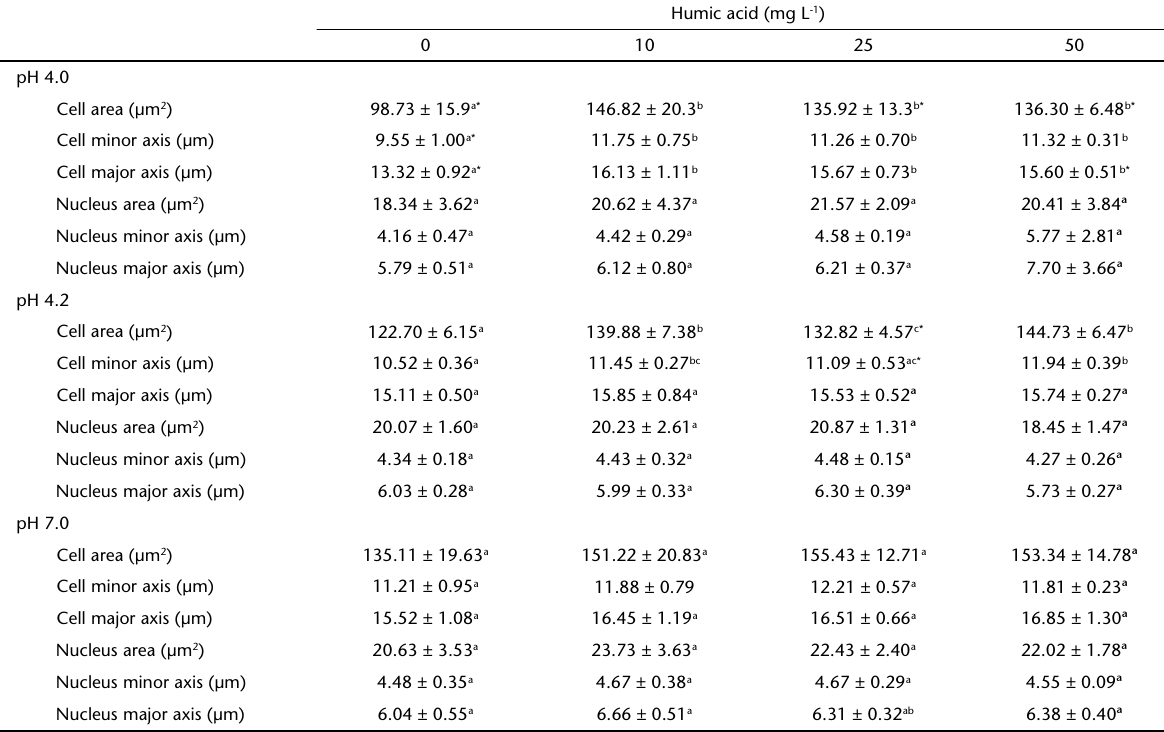
Table 3. Effect of humic acid and pH on erythrocyte morphology of Rhamdia quelen